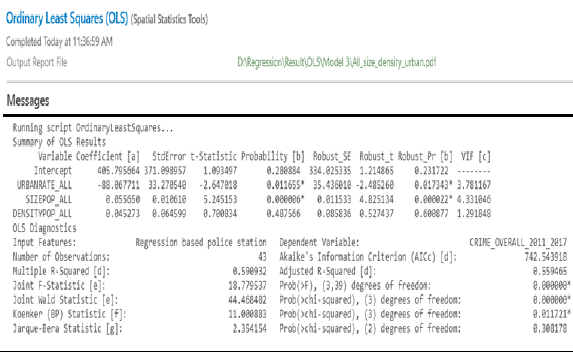
Table 4: OLS Regression result for urban crime